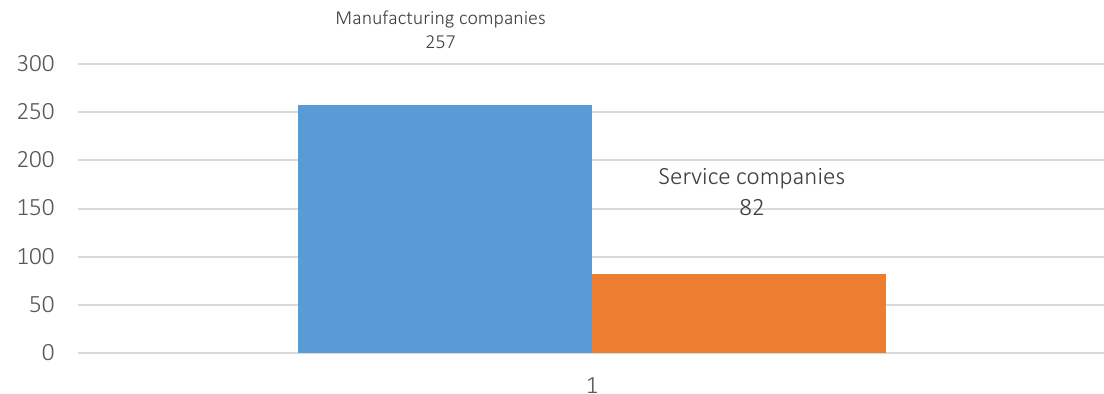
Figure 2. Classification of companies - industry type